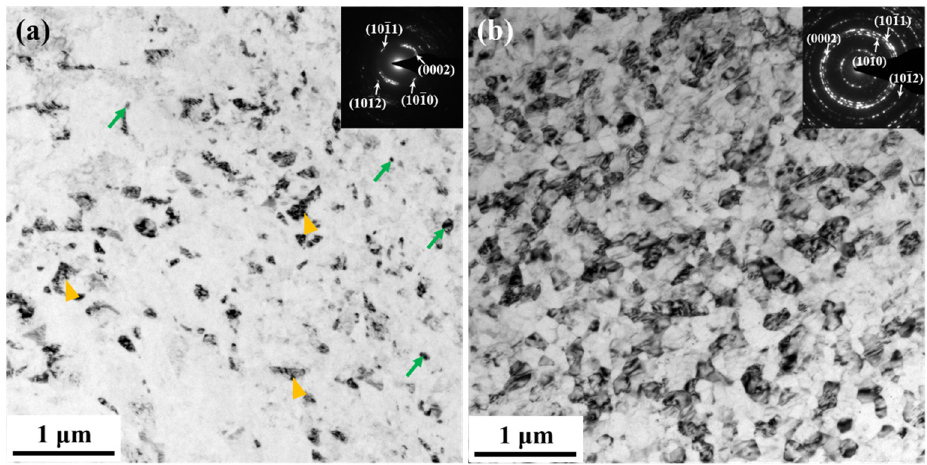
Figure 7. Microstructure in the central region of the alloy bars: ( a ) E9S-5 sample; ( b ) E25S-5 sample. The corresponding SAED patterns are provided as insets in the micrographs. The twin lamellae and nanograins are indicated by the yellow and green arrows, respectively.